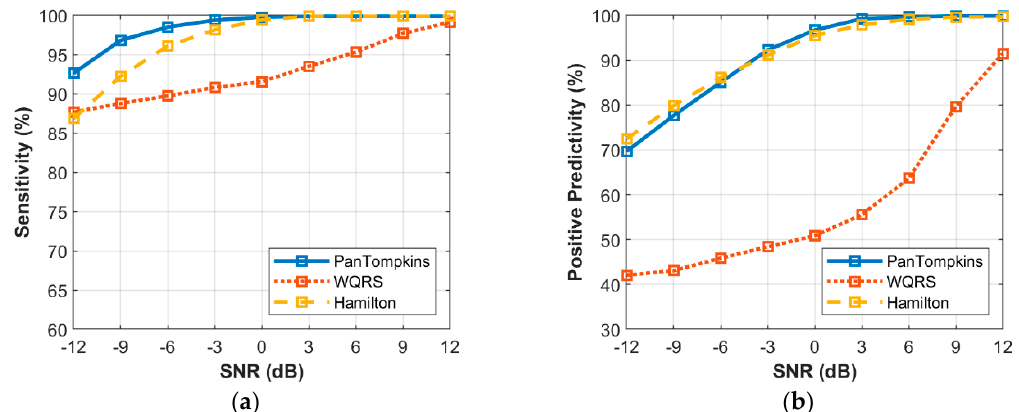
Figure 10. Relationship between the performance of beat detection and MA with abnormal signal for the record 200: ( a ) sensitivity with SNR; ( b ) positive predictivity with SNR.